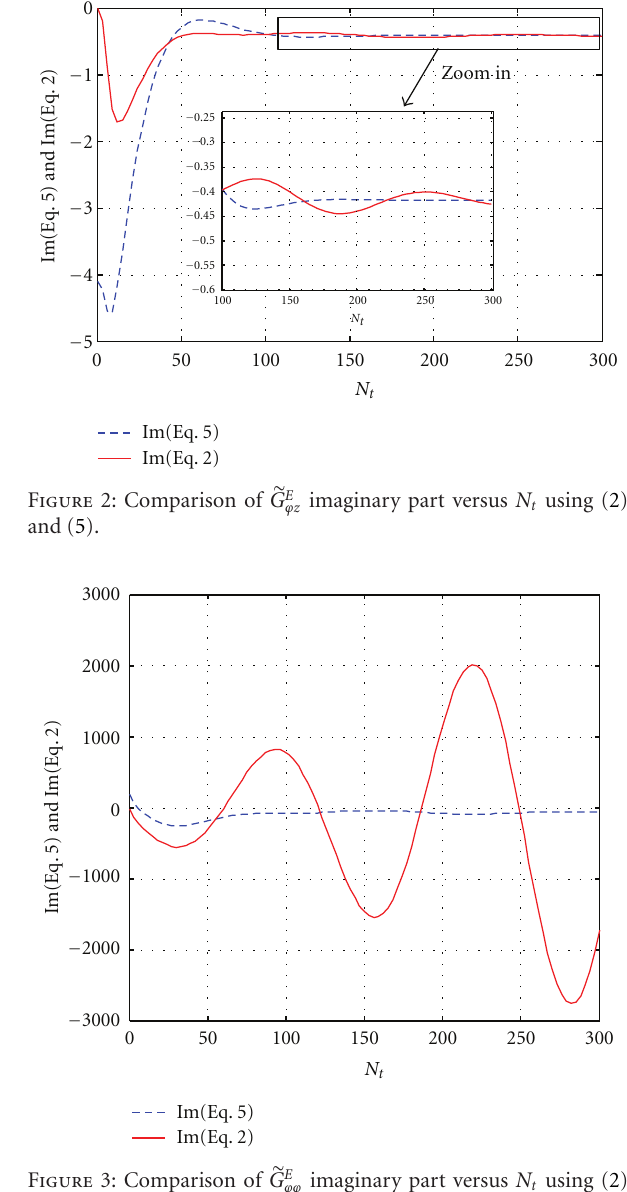
imaginary part versus N t using (2) ϕϕ